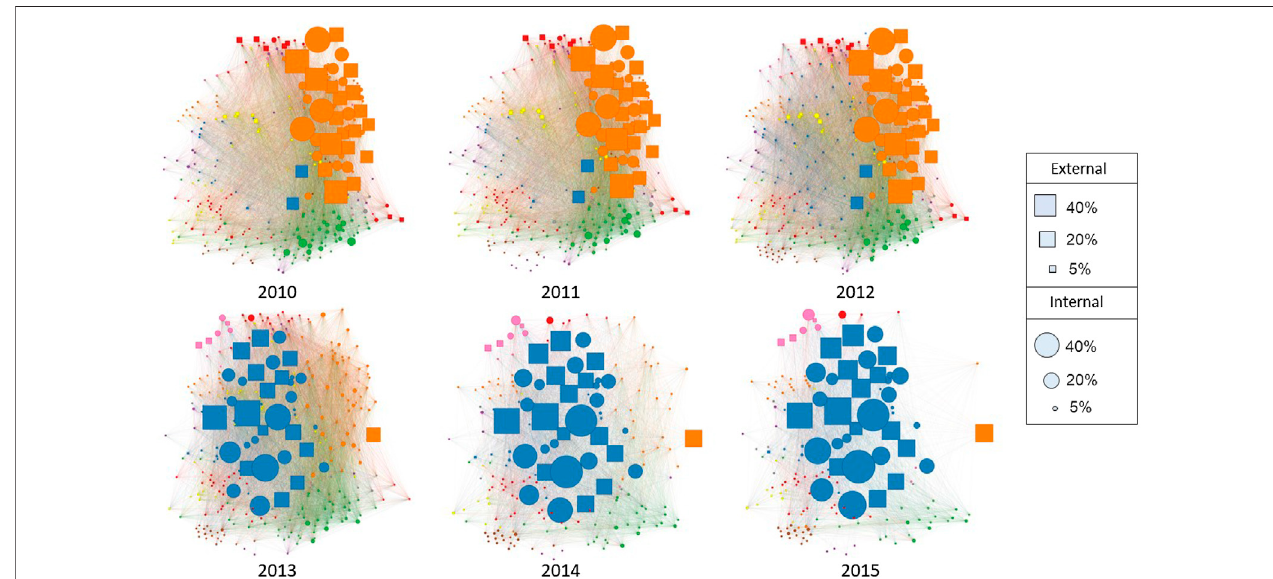
FIGURE 6 | Network of NCEA Level 3 Standards Across Years. The standard projection of the NCEA Level 3 co-enrolment network across years. Node size represents the number of students enrolled in each standard as a percentage of the total number of students in each cohort. As years progressed, the number of standards was reduced. Around 2013, a new set of science and mathematics achievement standards were introduced. Post-2013, the network is comprised mainly of one mathematics and science community, which indicates that assessment was more standardized than previous years.